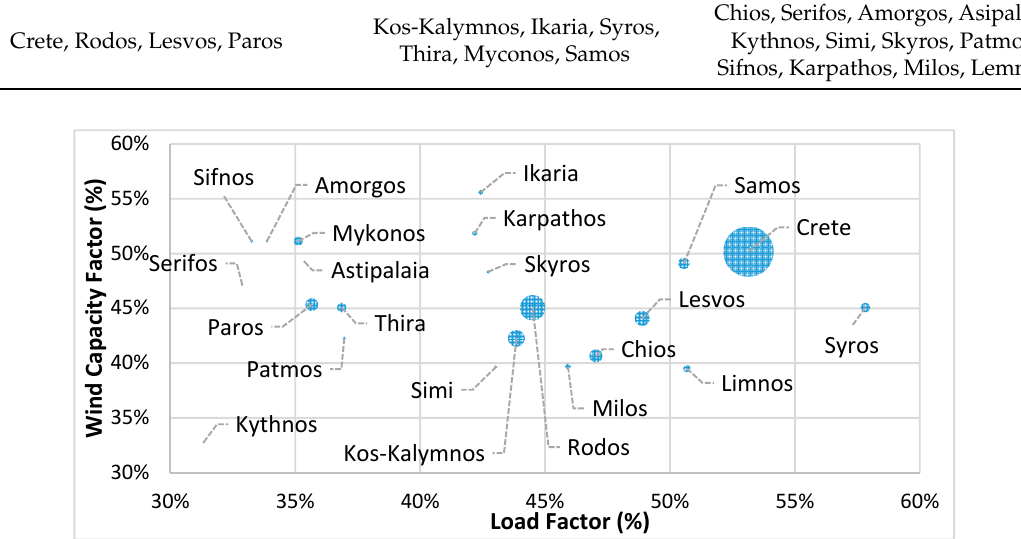
Figure 3. Overview of the examined case studies classified by their wind capacity factor (at 50 m height), load factor and load demand size. Fluids 2020 , 5 , 123